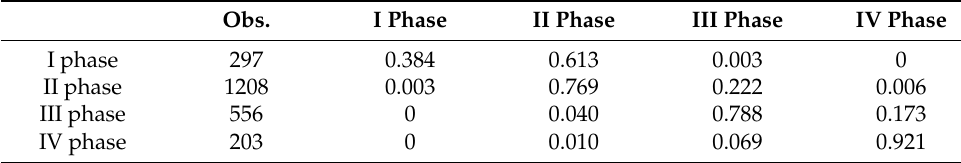
Table 4. Markov transition probability of digital economy from 2011 to 2019.